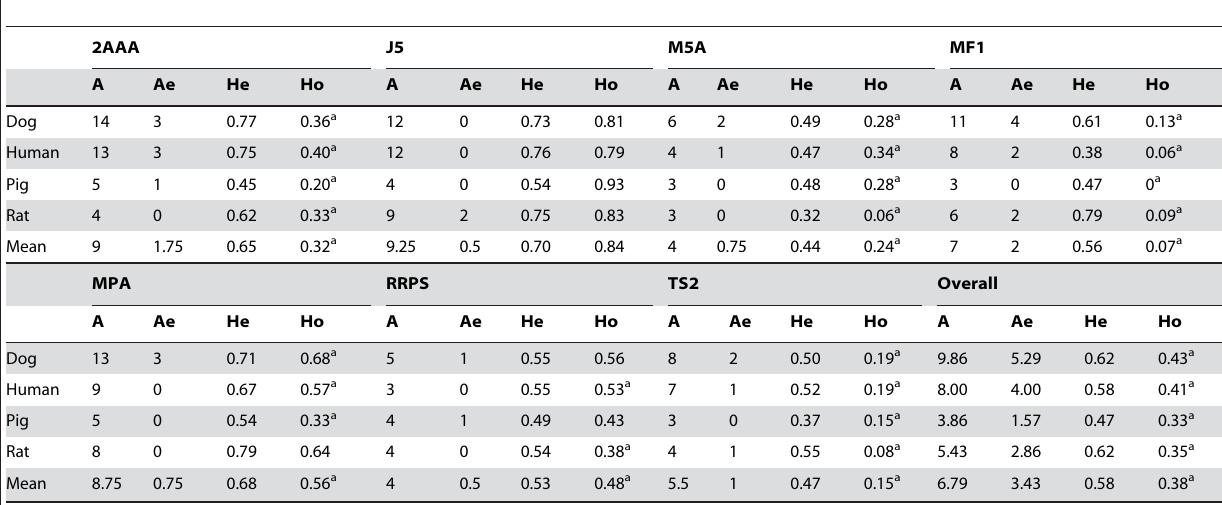
Table 2. Test for Hardy-Weinberg